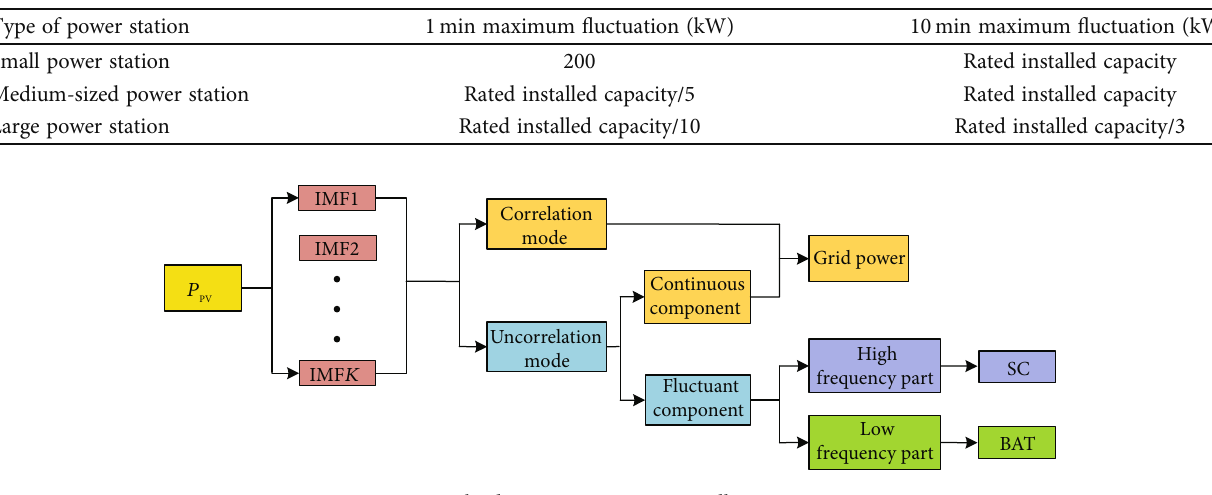
Table 1: Active power fl uctuation requirements of the photovoltaic power station.